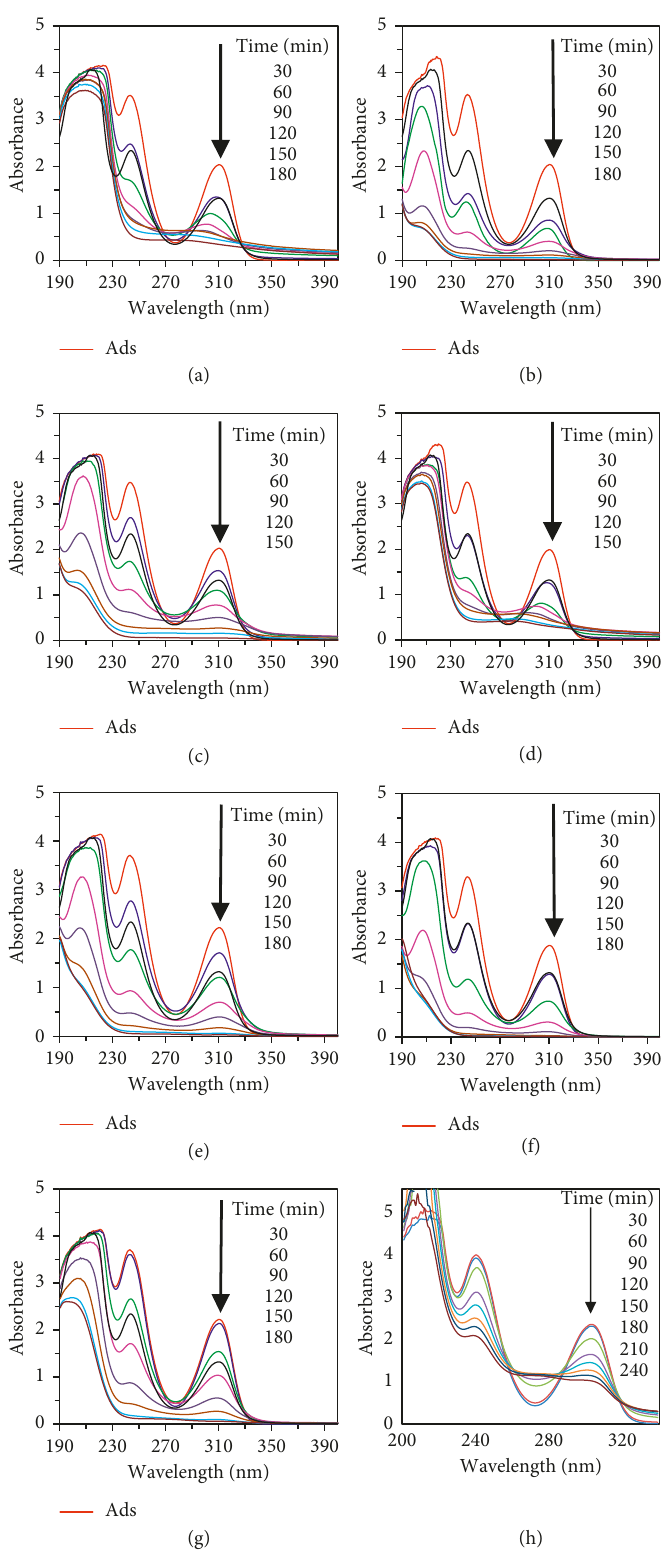
Figure 9: Absorption spectra of 100ppm of 2,4,6-trichlorophenol in the presence of different photocatalysts under UV light irradiation over time. (a) M1. (b) M2. (c) M3. (d) M4. (e) M5. (f) M6. (g) M7. (h) TiO 2